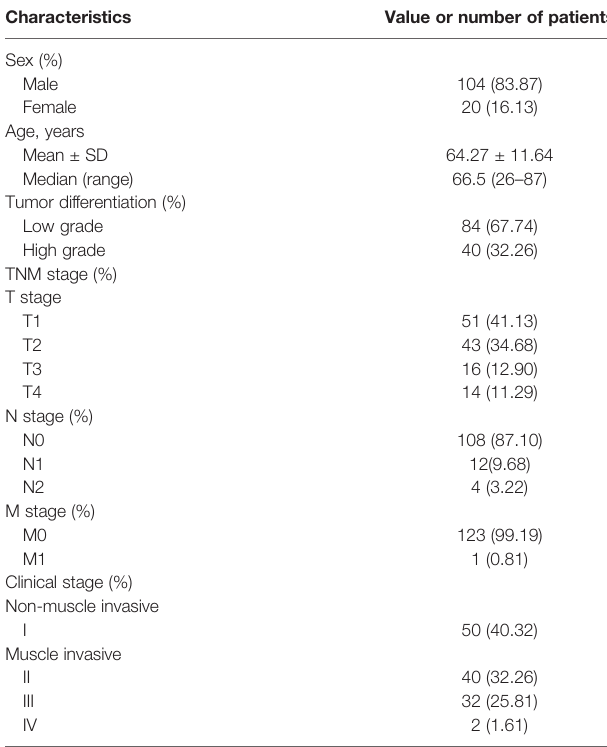
TABLE 1 | Clinical and pathological characteristics of the patients with UCB in this study (n = 124).